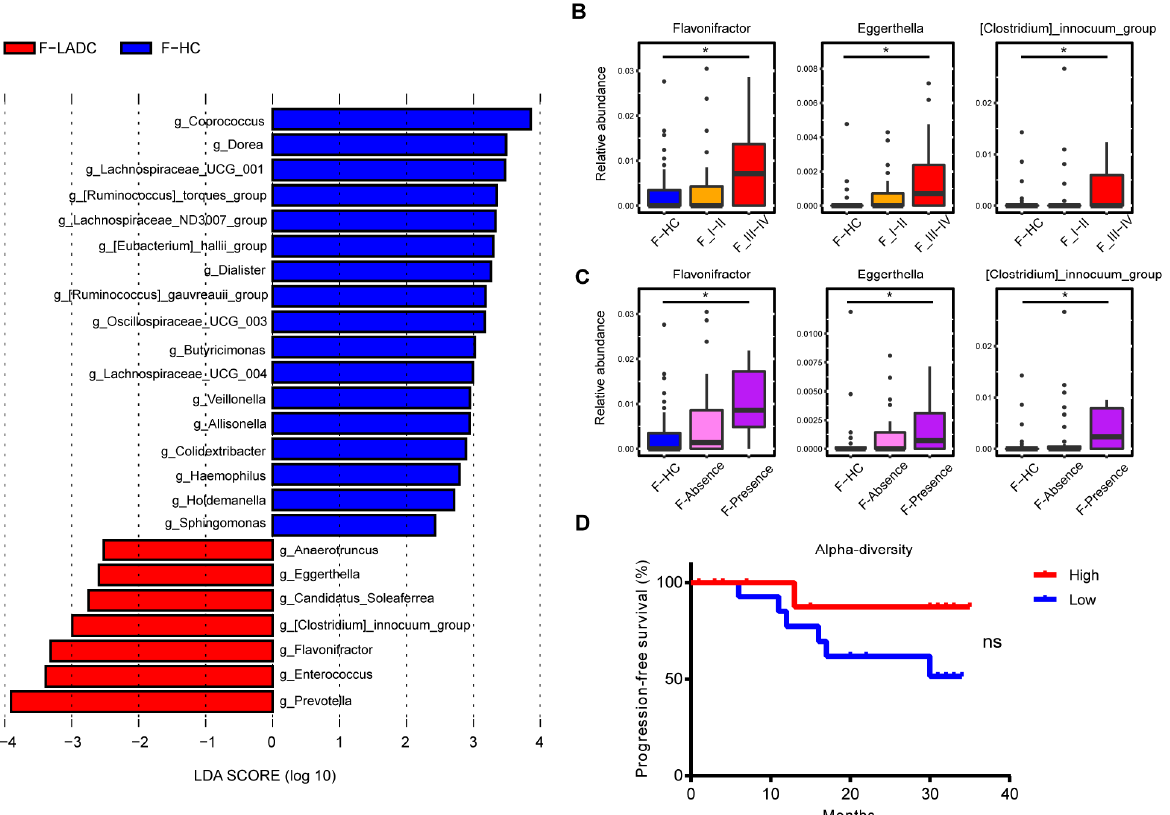
Figure 2. Differences in abundance of gut microbiota in patients with LADC and healthy controls. ( A ) Histogram of the LDA scores, where the LDA score indicates the effective size and ranking of taxa at the genus level (LDA > 2). Red and blue represent the patients with LADC (n = 43) and healthy controls (n = 64), respectively. Three genera were further analyzed in the disease stage ( B ) and distant metastasis ( C ). F-HC, healthy control group (n = 64); F_I-II, early-stage LADC group (n = 23); F_III-IV, advanced-stage LADC group (n = 20); F-Absence, non-metastatic LADC group (n = 33); F-Presence, metastatic LADC group (n = 10); p -values were calculated using the two-tailed Wil- coxon rank-sum test: *, p < 0.05. ( D ) Survival curves of progression-free survival by evenness index. High (red) vs. low (blue) diversity; log-rank (Mantel–Cox) analysis: ns, not significant.